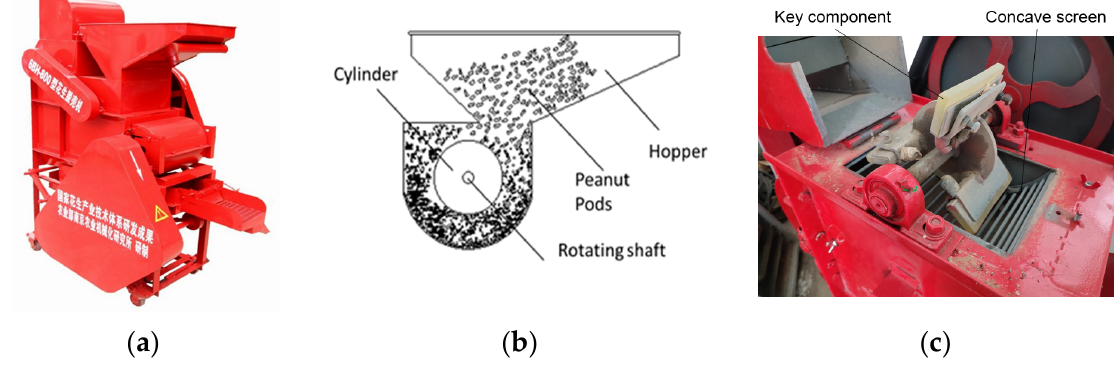
Figure 1. ( a ) Shelling machine (6BH-800 peanut sheller, designed by Nanjing Institute of Agricultural Mechanization, Ministry of Agriculture and Rural Affairs), ( b ) schematic diagram of the shelling bin, and ( c ) internal structure of the shelling bin.